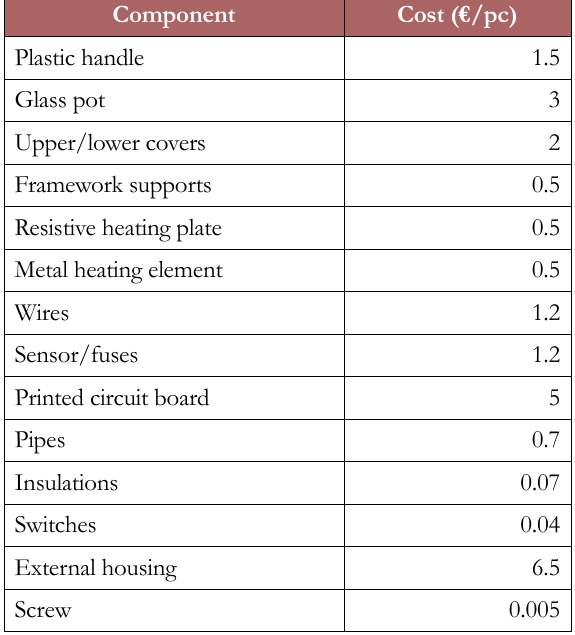
Table 1. Unit cost of the components of the coffee